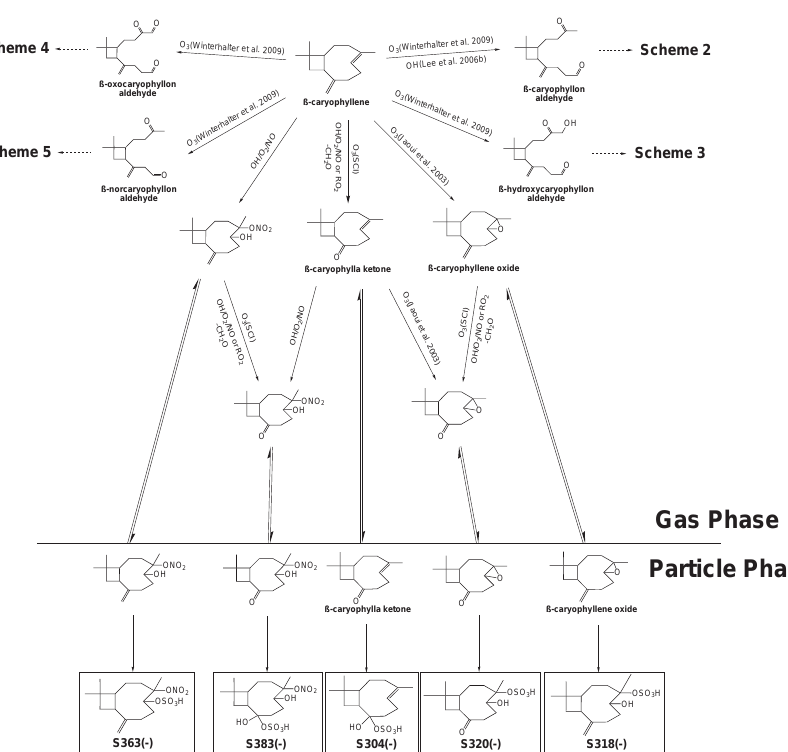
Scheme 1. Proposed reaction pathways of β -caryophyllene, leading to compounds detected by ESI in the particle phase. Boxes indicate compounds detected by ESI in the particle phase. One possible structural isomer is shown. SCI is the stabilized Criegee intermediates